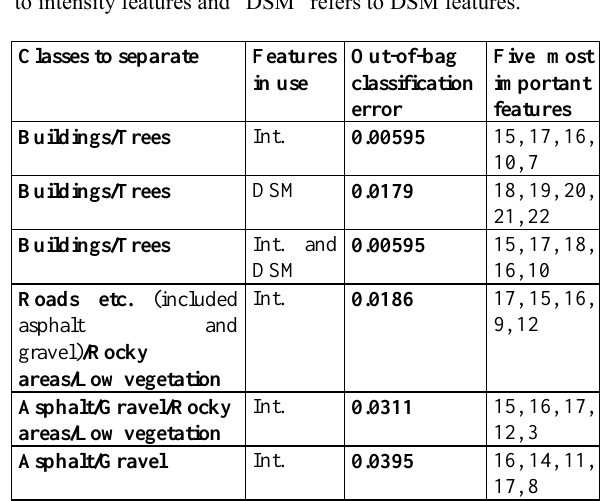
Table 2. Results of the random forests analysis. In each case, 1000 classification trees were created based on training